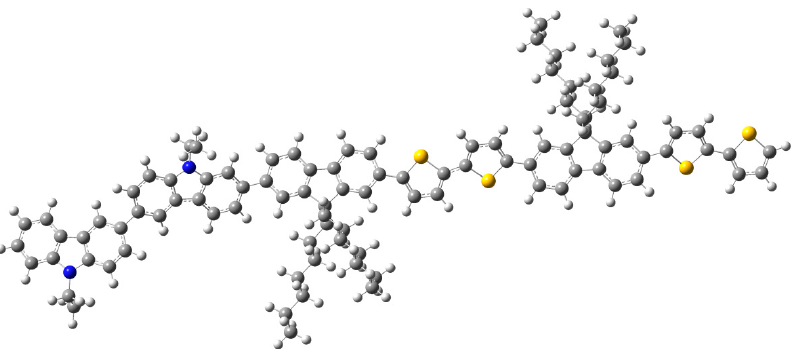
Figure 3. Optimized model structure of the PVK-F8T2.